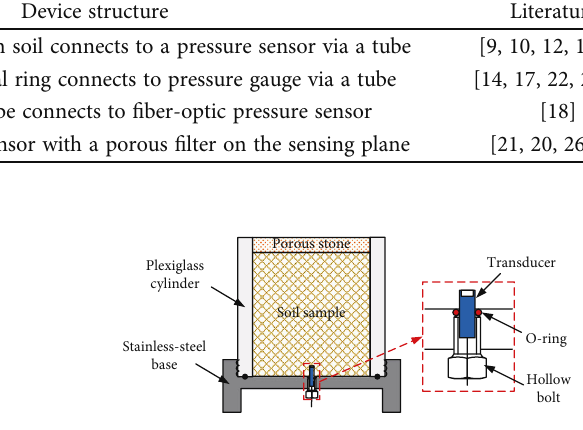
Figure 3: Laterally con fi ned compression